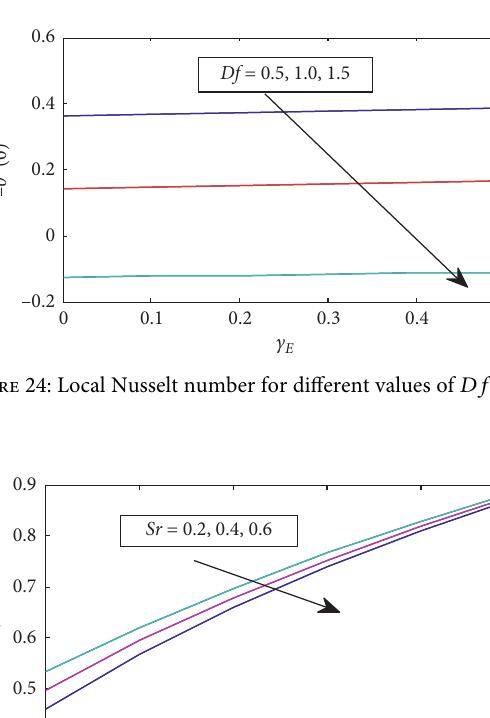
Figure 23: Local Sherwood number for different values of R versus λ .